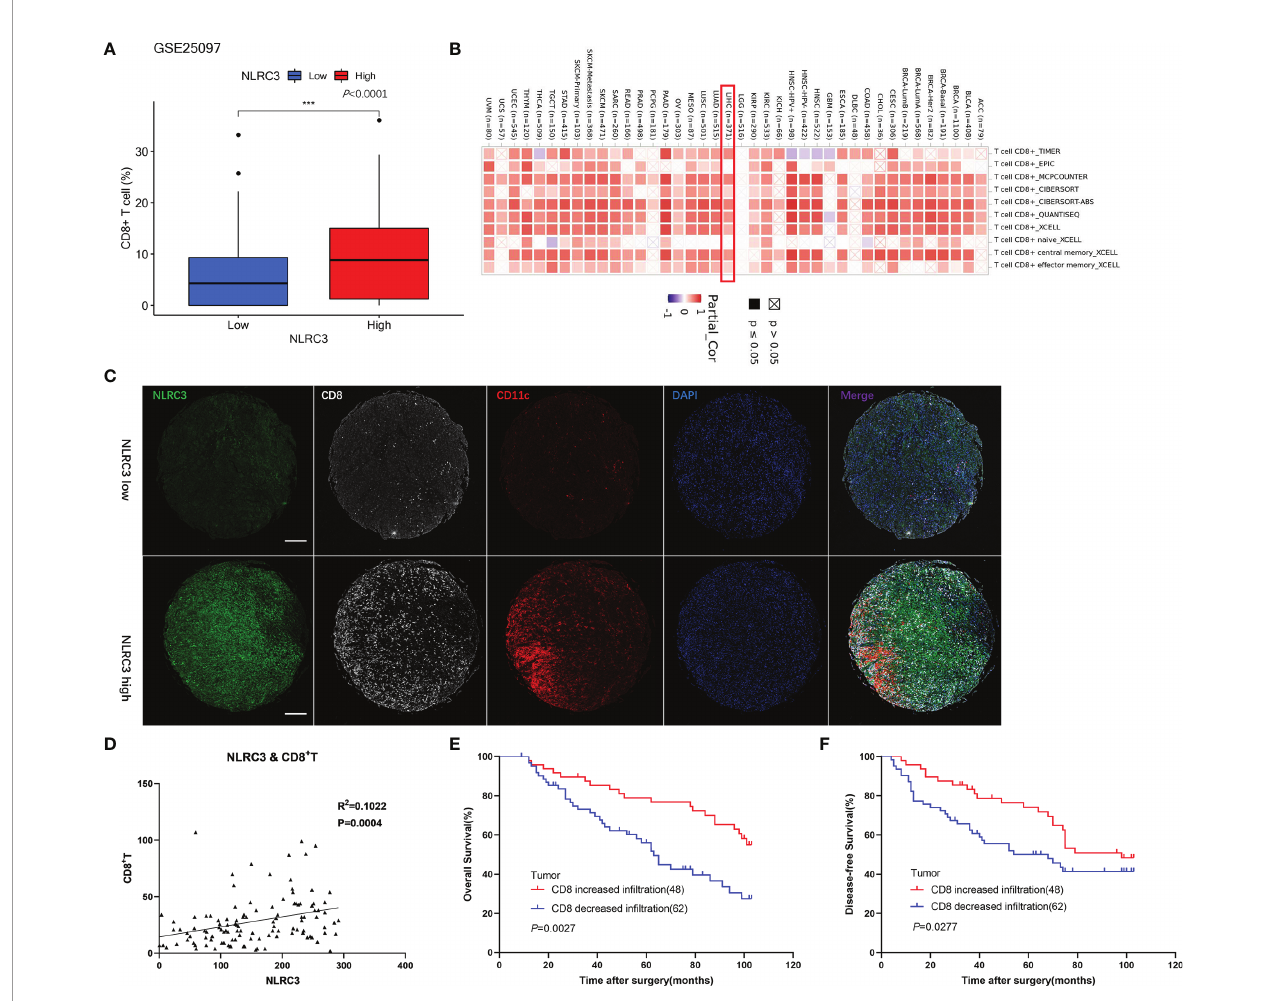
FIGURE 3 | Strong NLRC3 expression in HCC tissue positively correlated with high CD8 + T cell in fi ltration. (A) CD8 + T cells in high NLRC3 mRNA subgroups was higher than low NLRC3 mRNA subgroups from the GSE25097 datasets, data was showed as mean. (*** P <0.0001). (B) NLRC3 level and CD8 + T cell in fi ltration was positively correlated. (C) Representative mIHC images of two tumor tissue samples showing NLRC3, CD8 and CD11c staining in TMAs (magni fi cation 40×, scale bar=500 m m). (D) NLRC3 expression in HCC tissue positively correlated with CD8 + T cell in fi ltration ( P =0.0004), data were analyzed by Pearson ’ s R 2 correlation test. (E) The OS in CD8 increased in fi ltration group was higher than CD8 decreased in fi ltration group by Kaplan-Meier analysis ( P =0.0027). (F) The DFS in CD8 increased in fi ltration group was higher than CD8 decreased in fi ltration group by Kaplan-Meier analysis ( P